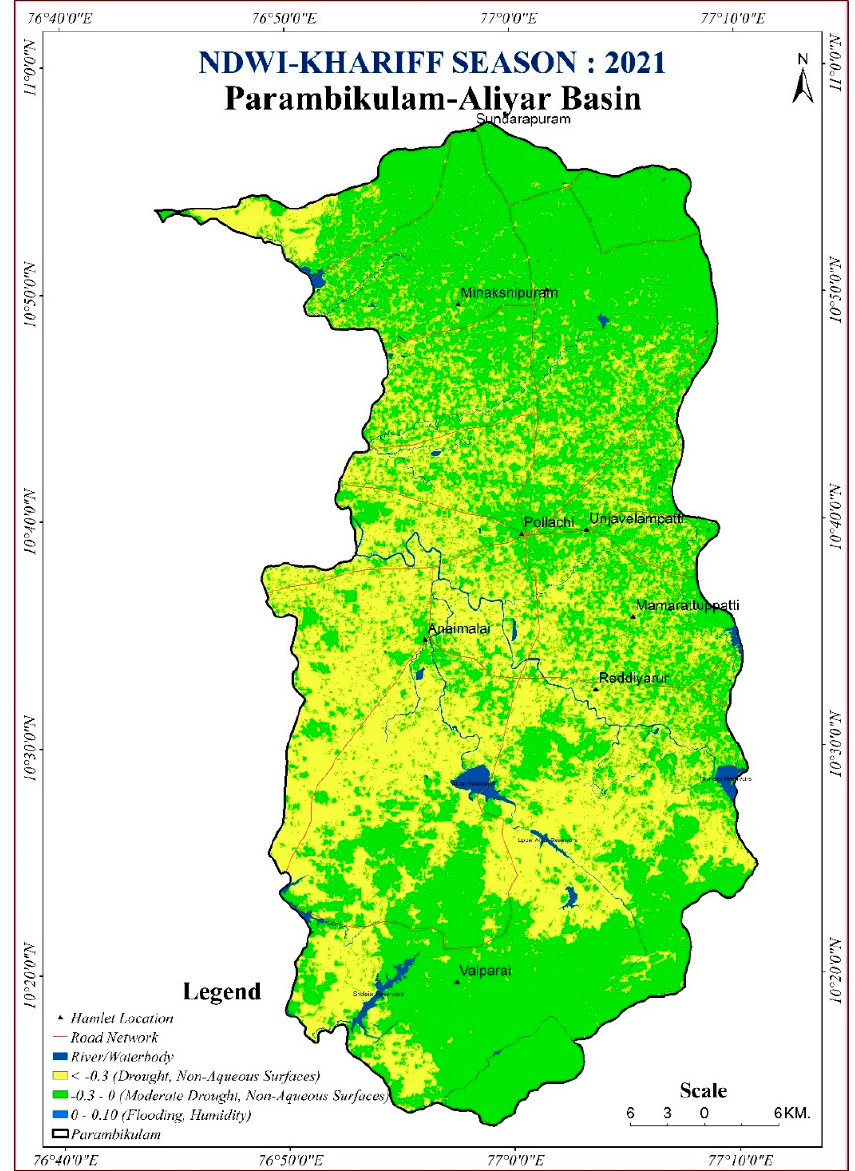
Figure 9 Mean NDWII for groundnut, Khariff growing season (June to September 2021). Figure 9. Mean NDWII for groundnut, Khariff growing season (June to September 2021). Higher mean TWI regions have a higher vulnerability to water retention or